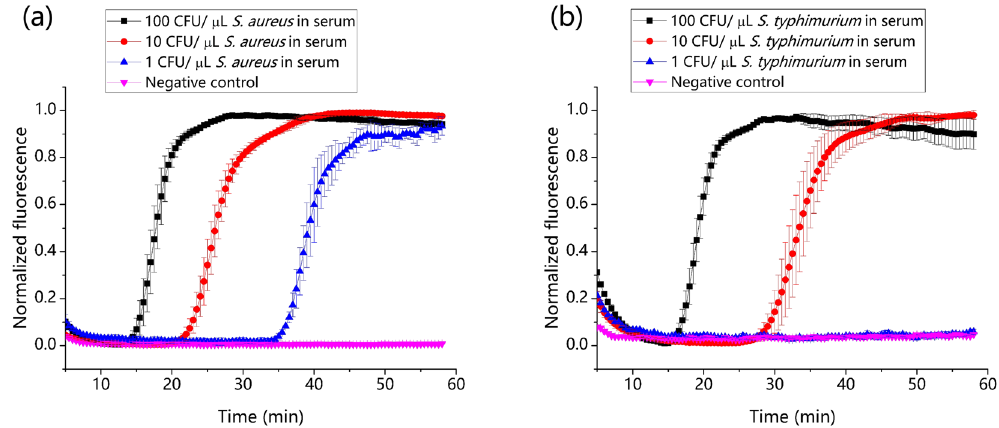
Figure 7. On-chip real-time amplification plot. ( a ) Detection of different concentrations of S. aureus . As low as 1 CFU μ L − 1 of S. aureus were detected from the serum sample. ( b ) Detection of different concentrations of S. typhimurium . Up to 10 CFU μ L − 1 of S. typhimurium were detected from the serum sample. The standard deviations of the fluorescence signals of the five reaction chambers used for each pathogen are depicted as error bars in the